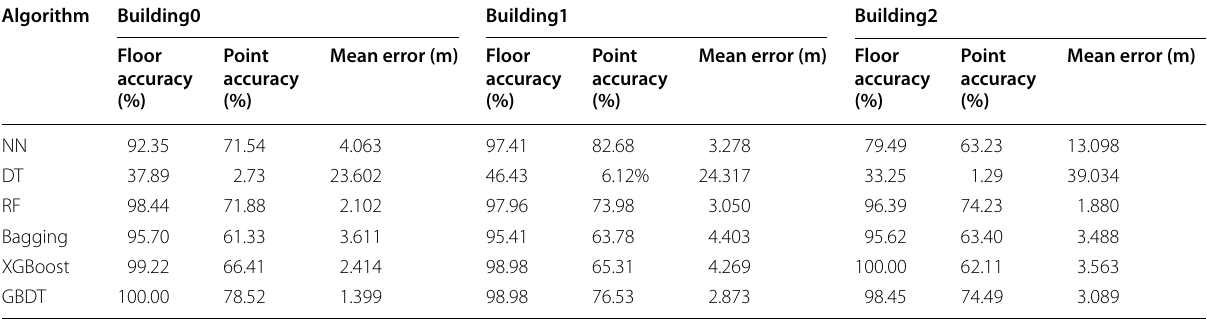
Table 5 The performance of different methods when the training data and validation data come from the same building